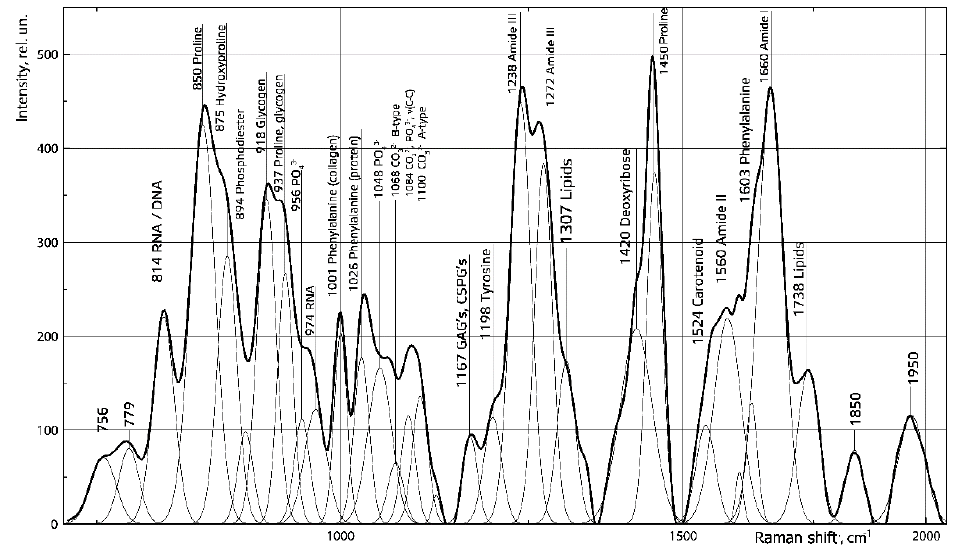
Figure 5. Spectral contour decomposition of demineralized spongiosa samples. The solid line-original Raman spectrum; the dashed lines-the Raman lines after separation.